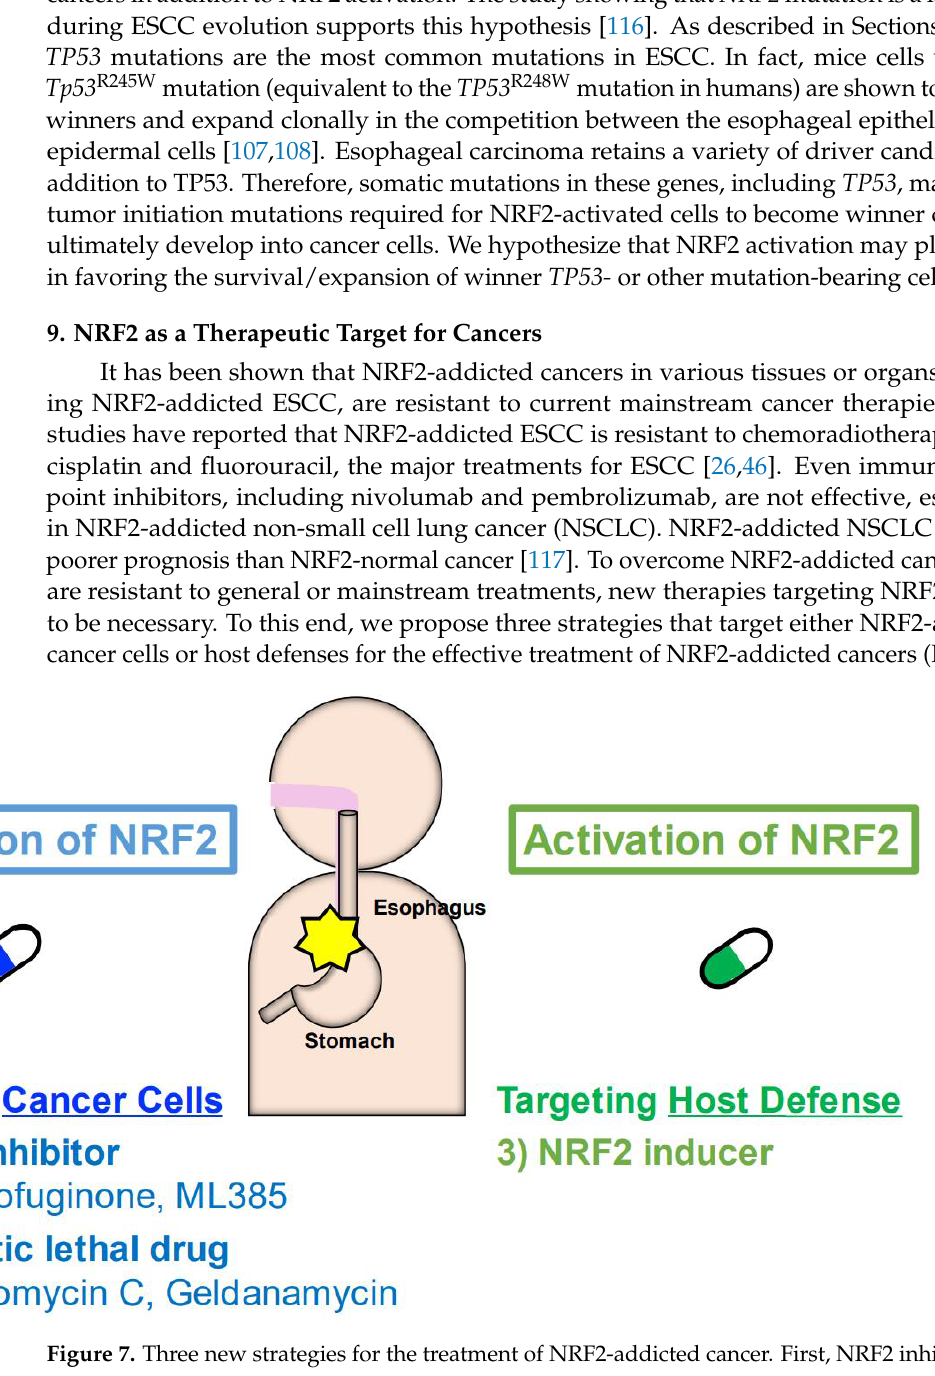
Figure 7. Three new strategies for the treatment of NRF2-addicted cancer. First, NRF2 inhibitors, in- cluding halofuginone and ML385, can act to target NRF2-addicted cancer cells. Second, synthetic lethal drugs will target NRF2-addicted cancer cells; this group includes mitomycin C and geldanamycin. Third, NRF2 inducers can activate the host defense system surrounding NRF2-addicted